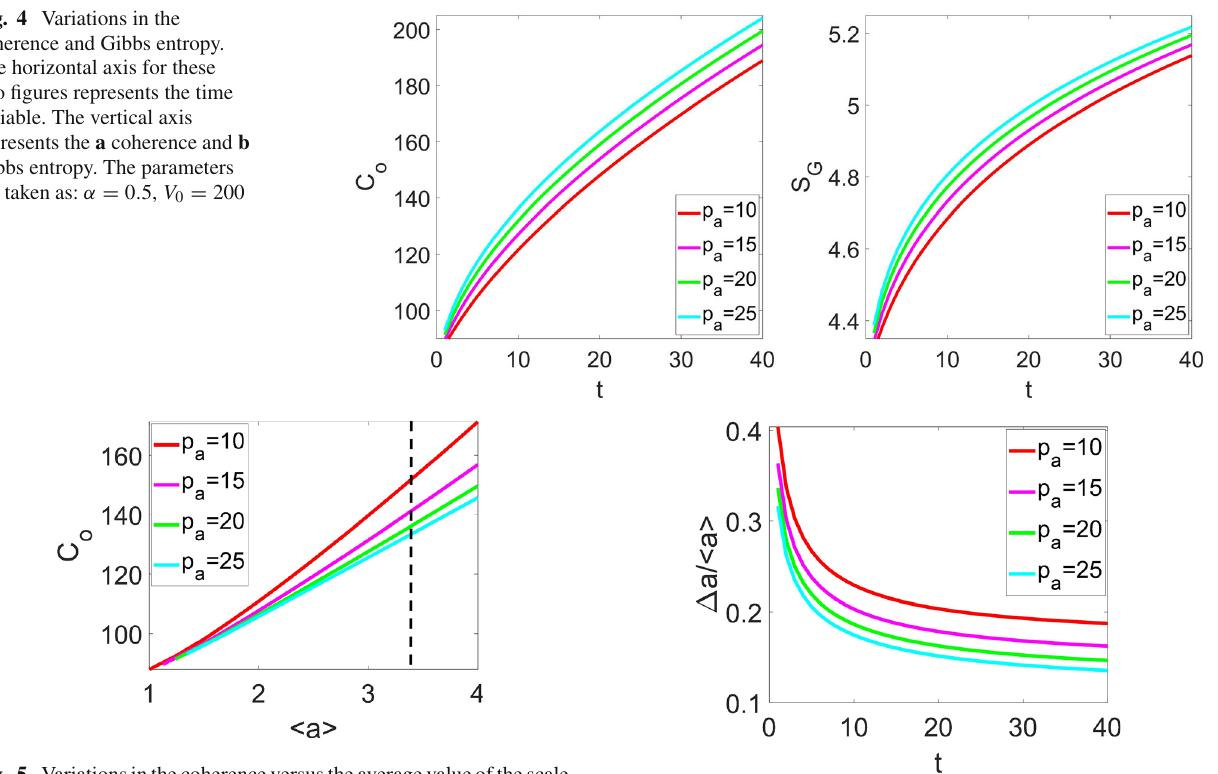
Fig. 7 Variations in the relative quantum fluctuation ( (cid:14) a / (cid:7) a (cid:2) ). The horizontal and vertical axes represent the time variable and (cid:14) a / (cid:7) a (cid:2) , respectively. The parameters are taken as: α = 0 . 5, V 0 = 200